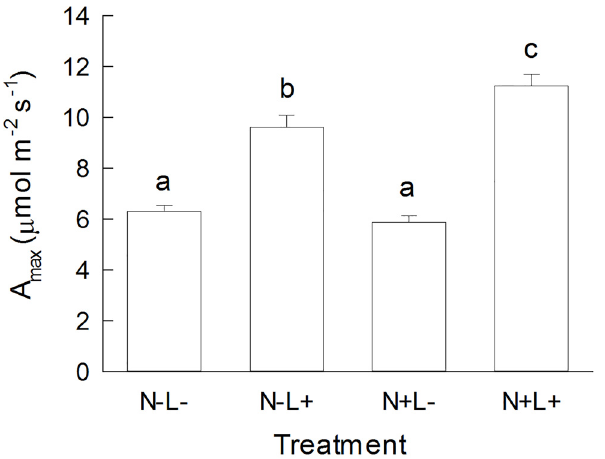
Fig 4. Maximum rate of photosynthesis (A max ) of Plantago lanceolata . Plants were grown at different light and nutrient availability (N-: low nutrient, N+: high nutrient, L-: low light, L+: high light). A max is measured as CO 2 uptake ( μ mol m -2 s -1 ). Values are means across all plants per treatment (+ 1 SE). Results of Tukey`s test applied to test for significant differences between different light x nutrient treatments are indicated with letters.